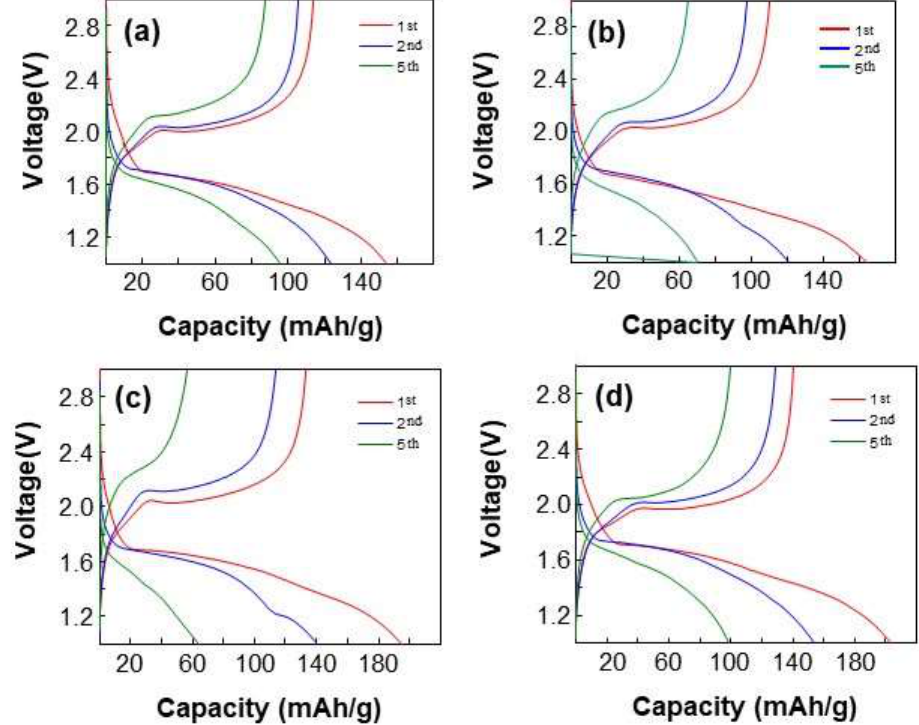
Figure 4. Charging/discharging curves of TiO 2 powders prepared at the various synthesis temperatures:( a ) 170 ◦ C; ( b ) 190 ◦ C; ( c ) 210 ◦ C; and ( d ) 230 ◦ C cycled between 1.0 and 3.0 V at a constant current rate of 0.12 C.